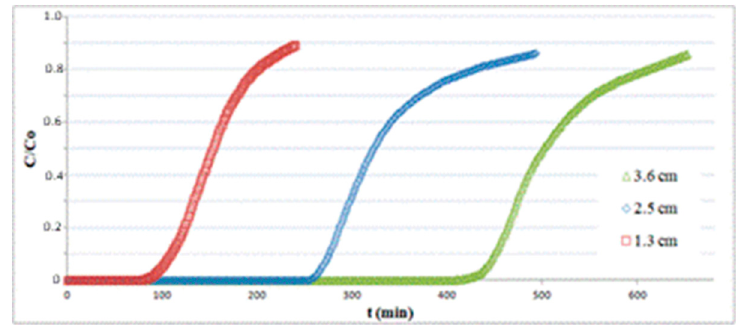
Figure 6. Adsorption tests on hematite powder with different bed lengths. Table 1. Adsorption performance of hematite powder as a function of bed length at T = 25 °C.